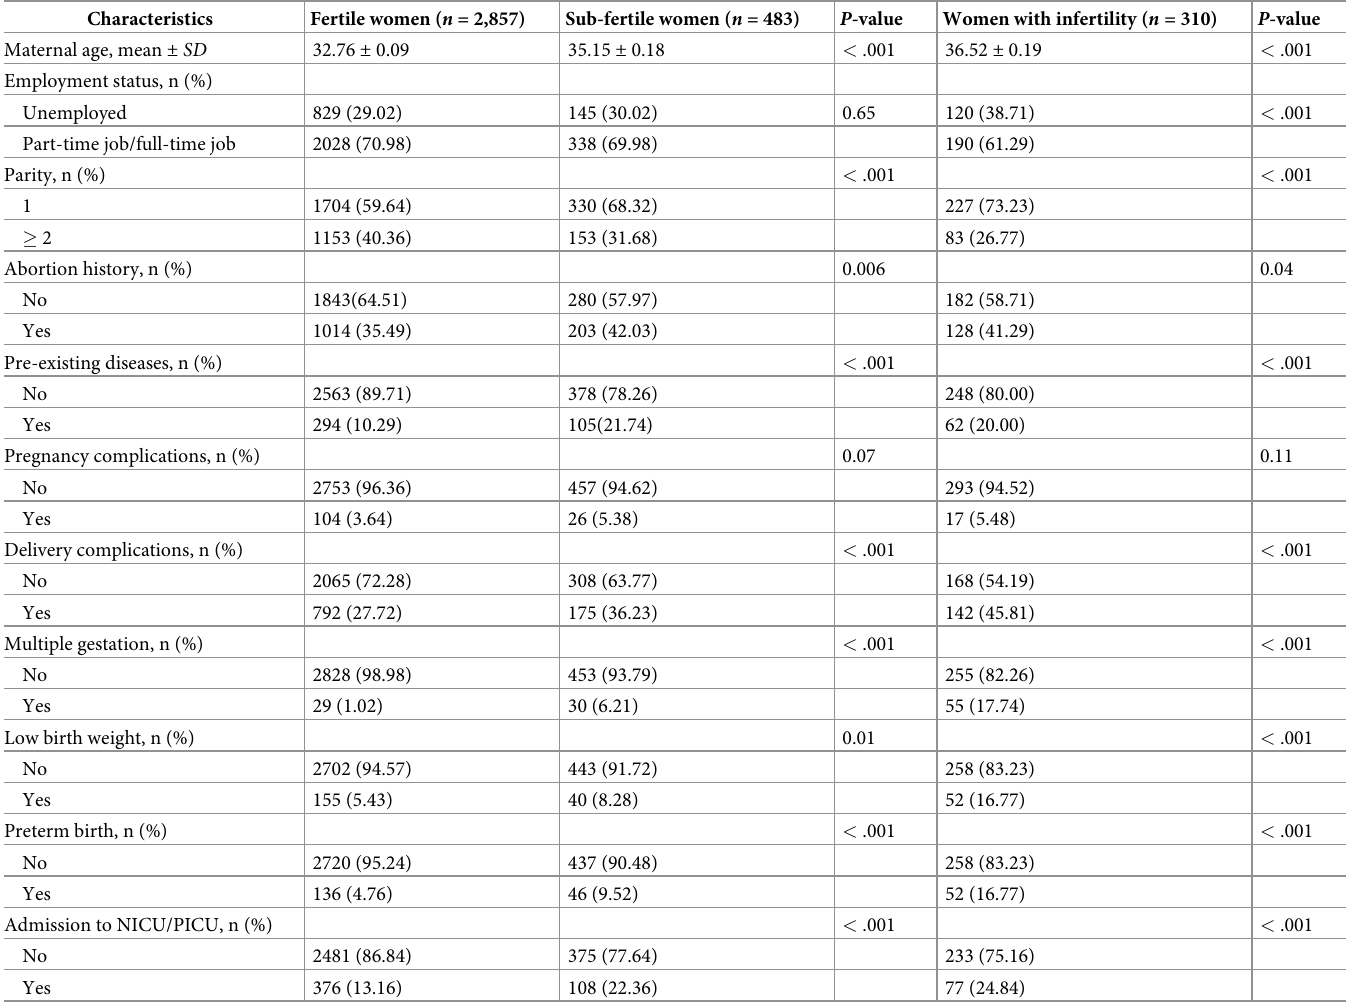
Table 1. Maternal and infant characteristics by mode of conception (N =